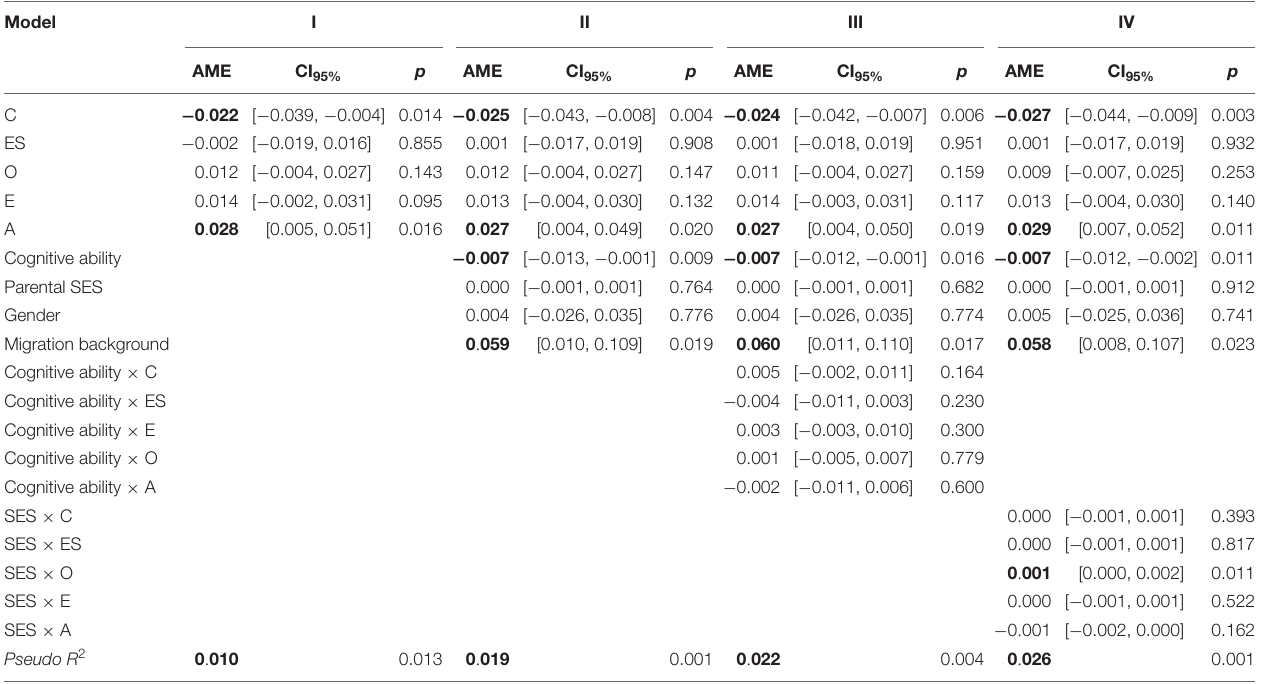
TABLE 7 | Average marginal effects for actual dropout regressed on the Big Five and the covariates.